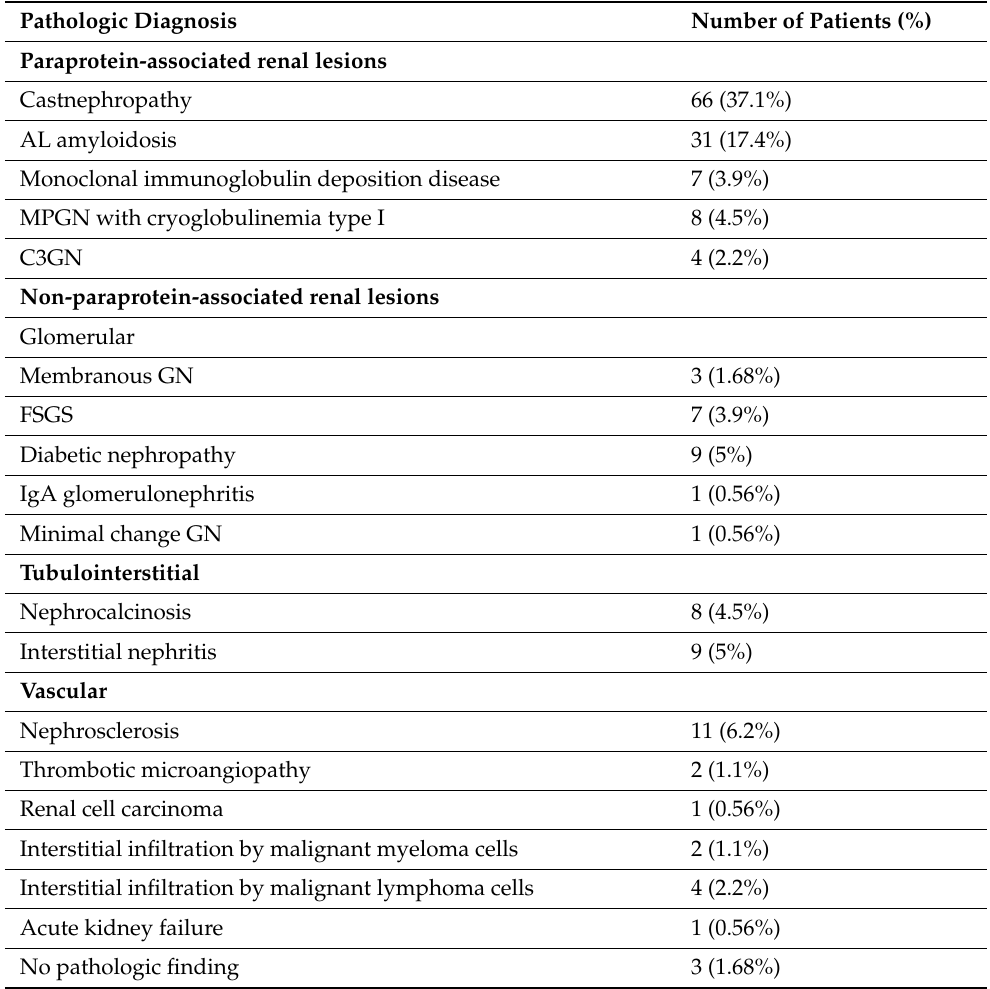
Table 2. Pathologic